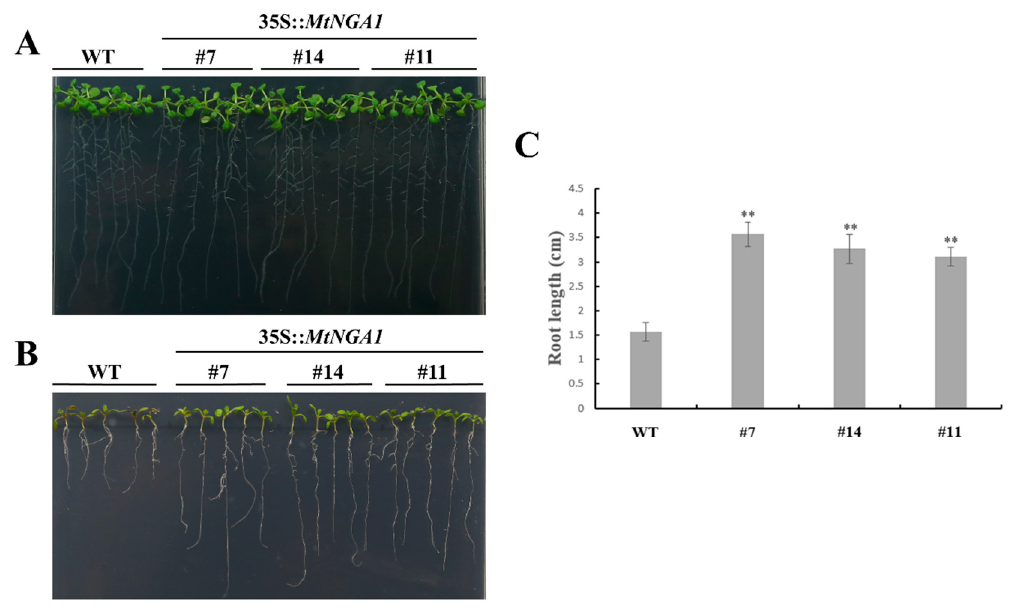
Figure 9. Phenotype assay of transgenic seedlings treated with ABA. ( A ) Five-day-old seedlings of transgenic lines and WT plants were planted on 1 / 2 MS medium without ABA and grown for 12 days. ( B ) Five-day-old seedlings of transgenic lines and WT plants were planted on 1 / 2 MS medium with 20 µ M ABA and grown for 12 days. ( C ) The primary root of transgenic lines and WT plants were measured at 12 days after 20 µ M ABA treatment. The values are the means ± SDs. * indicates significant di ff erences of the means at p < 0.05 between transgenic lines and WT plants ( n = 30). ** indicates significant di ff erences of the means at p < 0.01 between transgenic lines and WT plants ( n = 30).